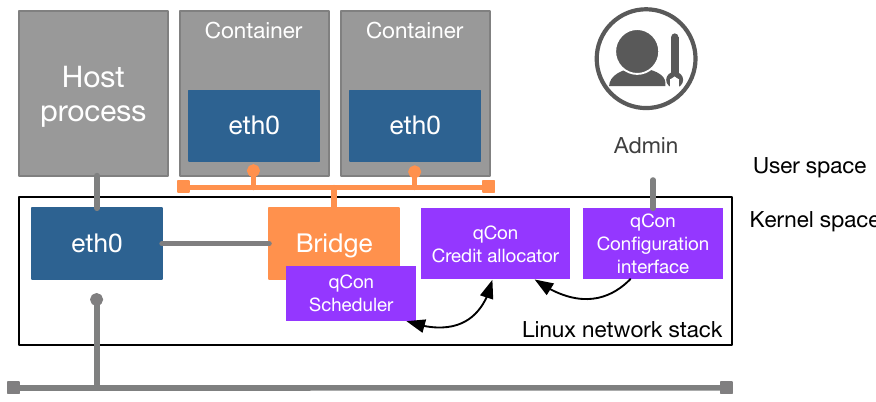
Figure 4. qCon components.